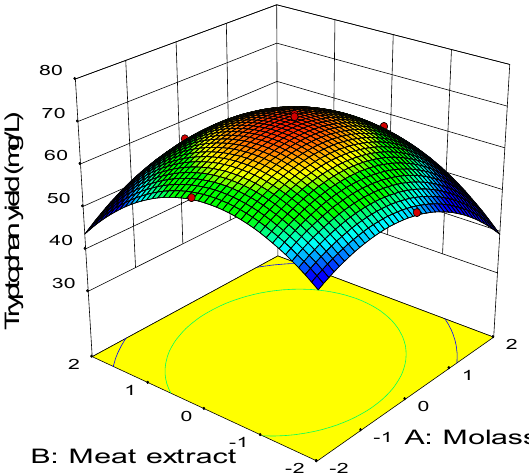
Figure 3. Response surface of tryptophan production by P. acidilactici TP-6 as a function of molasses and meat extract.